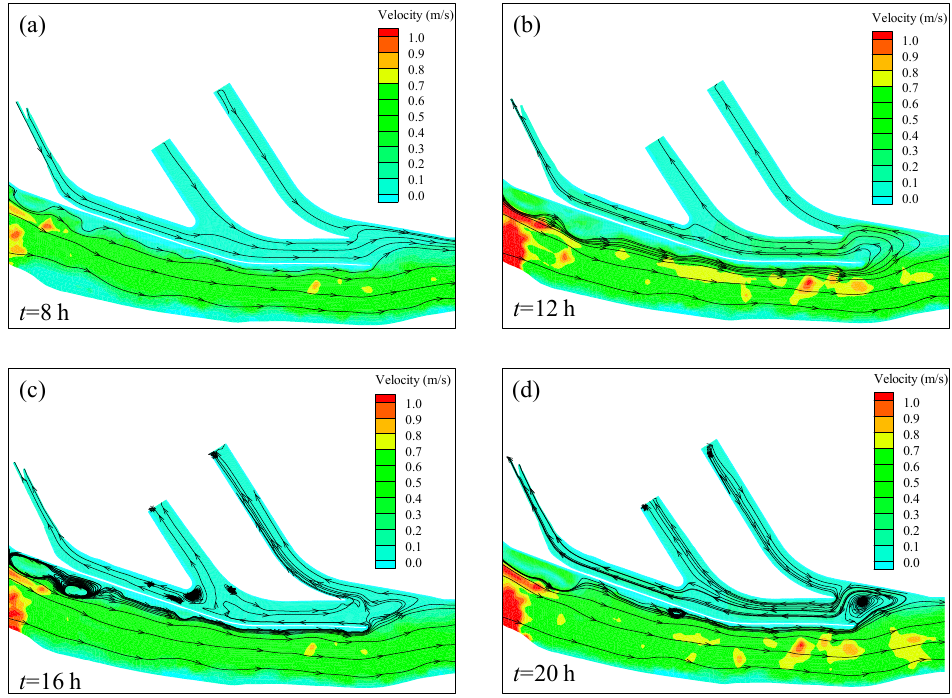
Figure 18. The typical streamline and velocity in multi-approach channels under double-peak regulation of hydropower stations. ( a ) t = 8 h; ( b ) t = 12 h; ( c ) t = 16 h; ( d ) t = 20 h.